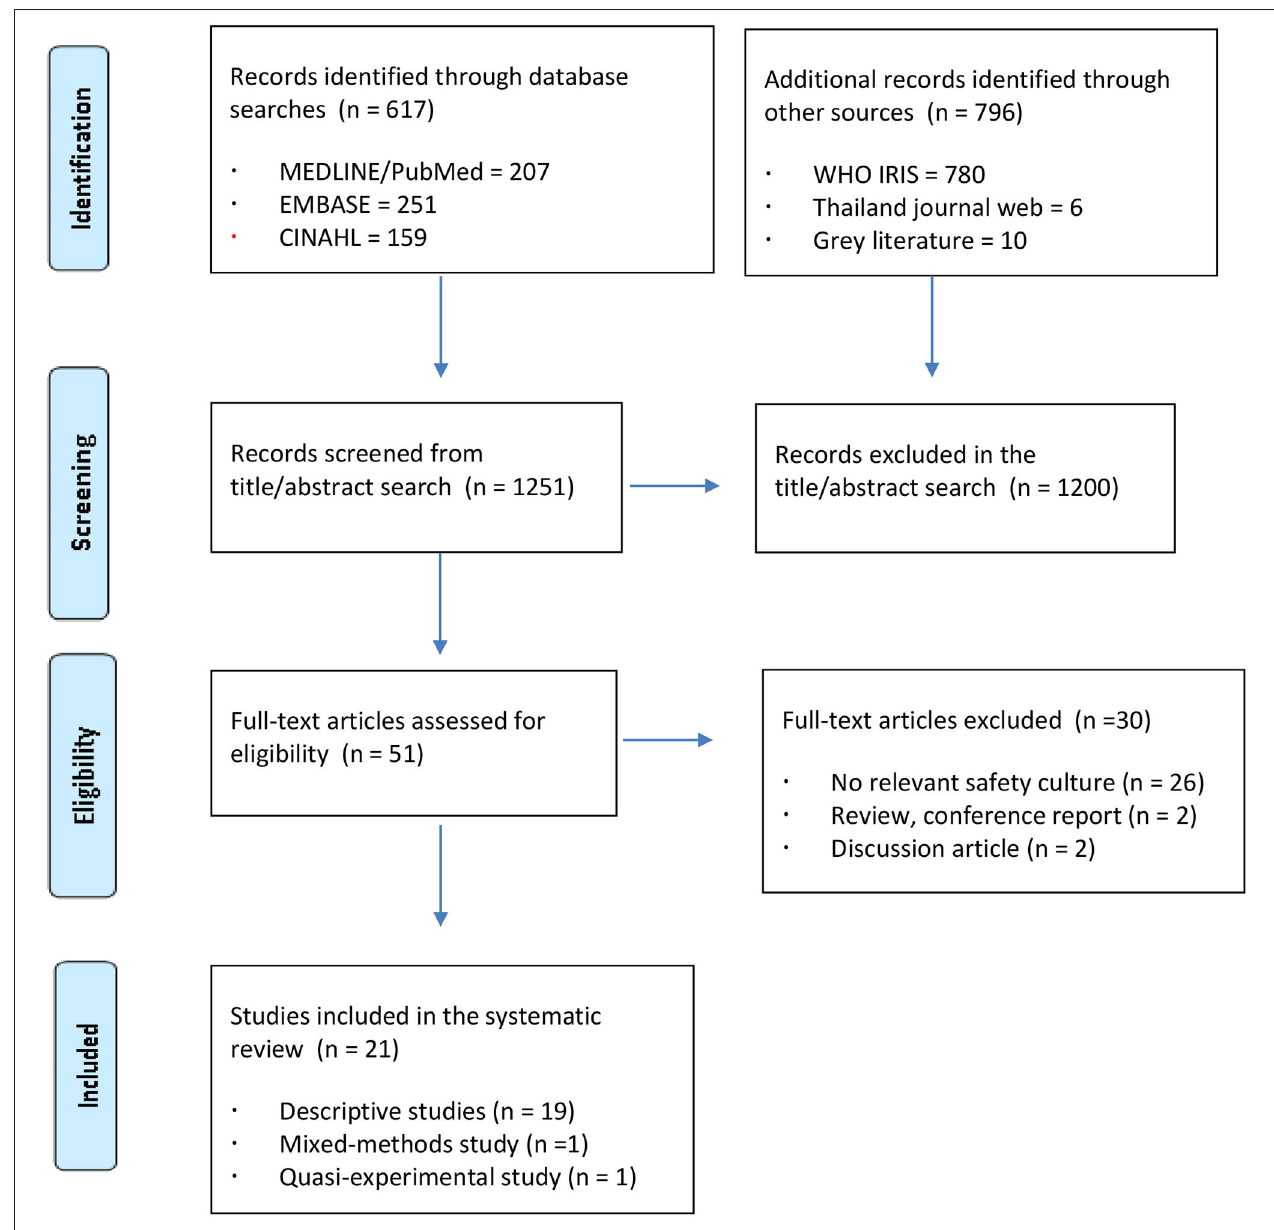
FIGURE 1 | Flow diagram of the study selection process.